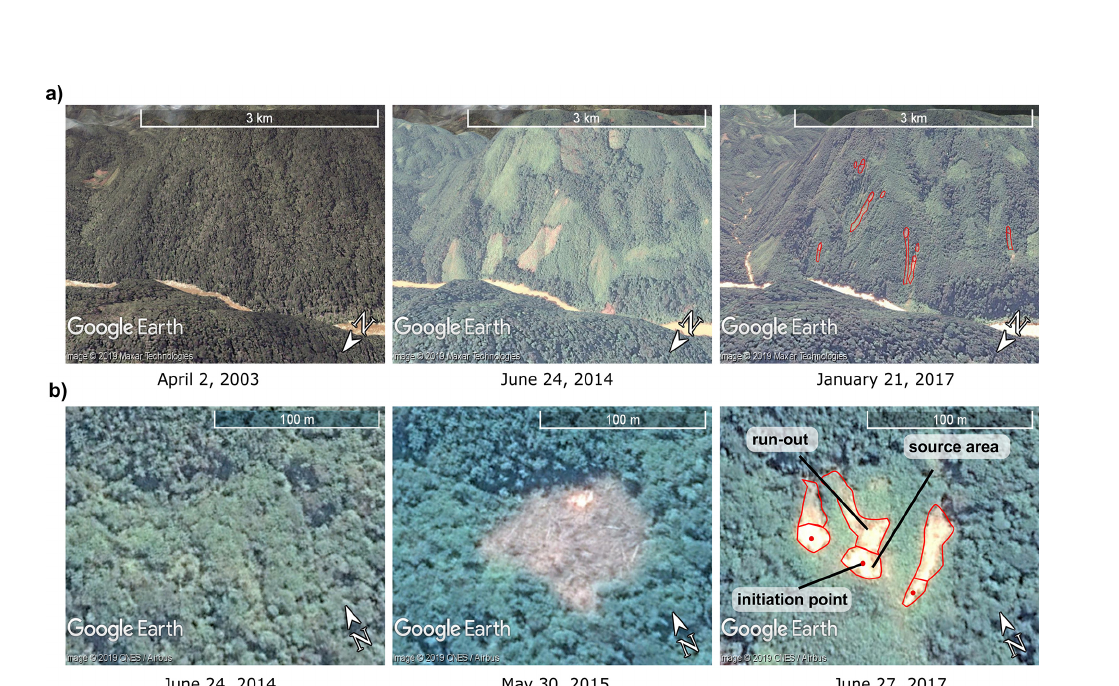
Figure 4. Examples of deforestation followed by landsliding. The left column shows the area prior to deforestation. The middle column shows the area after deforestation but prior to landsliding. The right column shows the area after landsliding. (a) Landslide event north of Butezi, DRC (2.843201 ◦ S, 28.296984 ◦ E; image © 2019 Google Earth). (b) Landslide event in Matale, DRC (2.645874 ◦ S, 28.360656 ◦ E; image © 2019 Google